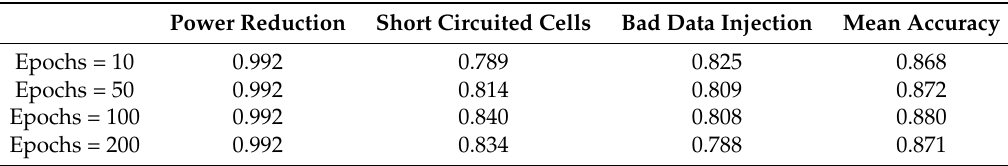
Table 5. Impact of the epochs on